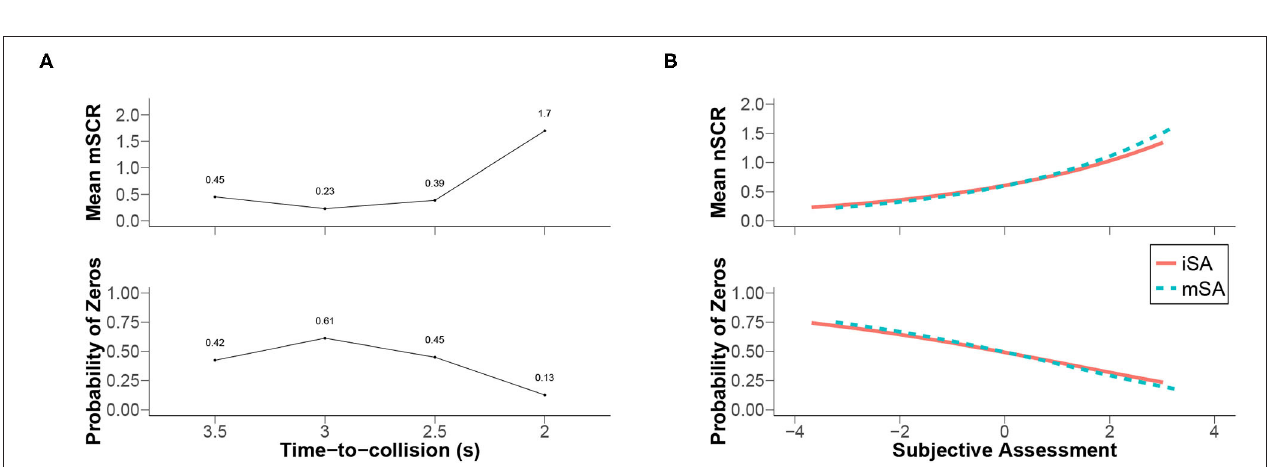
FIGURE 7 | Means for the SA variables for level combinations of TTC and offset. (A) The means of the indicator mSA in combination with the TTC and offset. (B) The means of the indicator iSA in combination with the TTC and offset. To better distinguish differences, confidence intervals at 95% are represented for each mean.